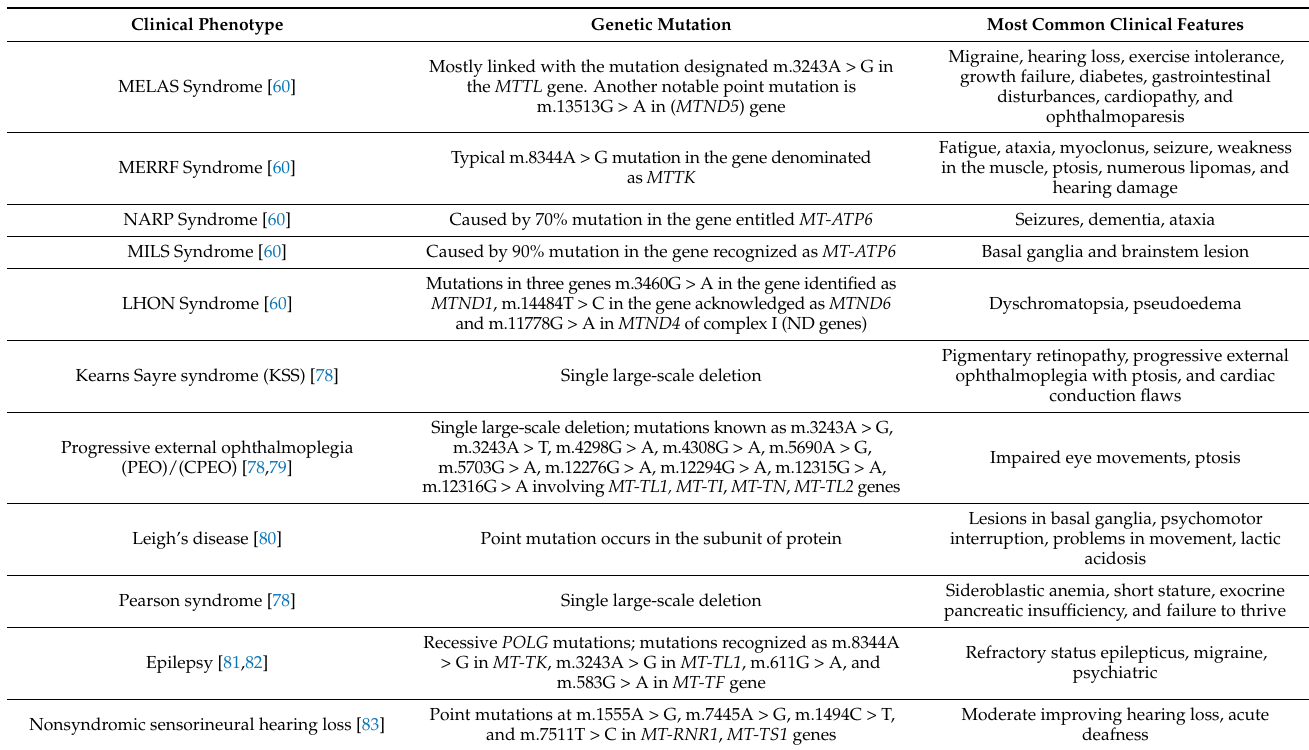
Table 1. Summary of clinical phenotypes, genetic mutations, and common clinical features of mitochondrial